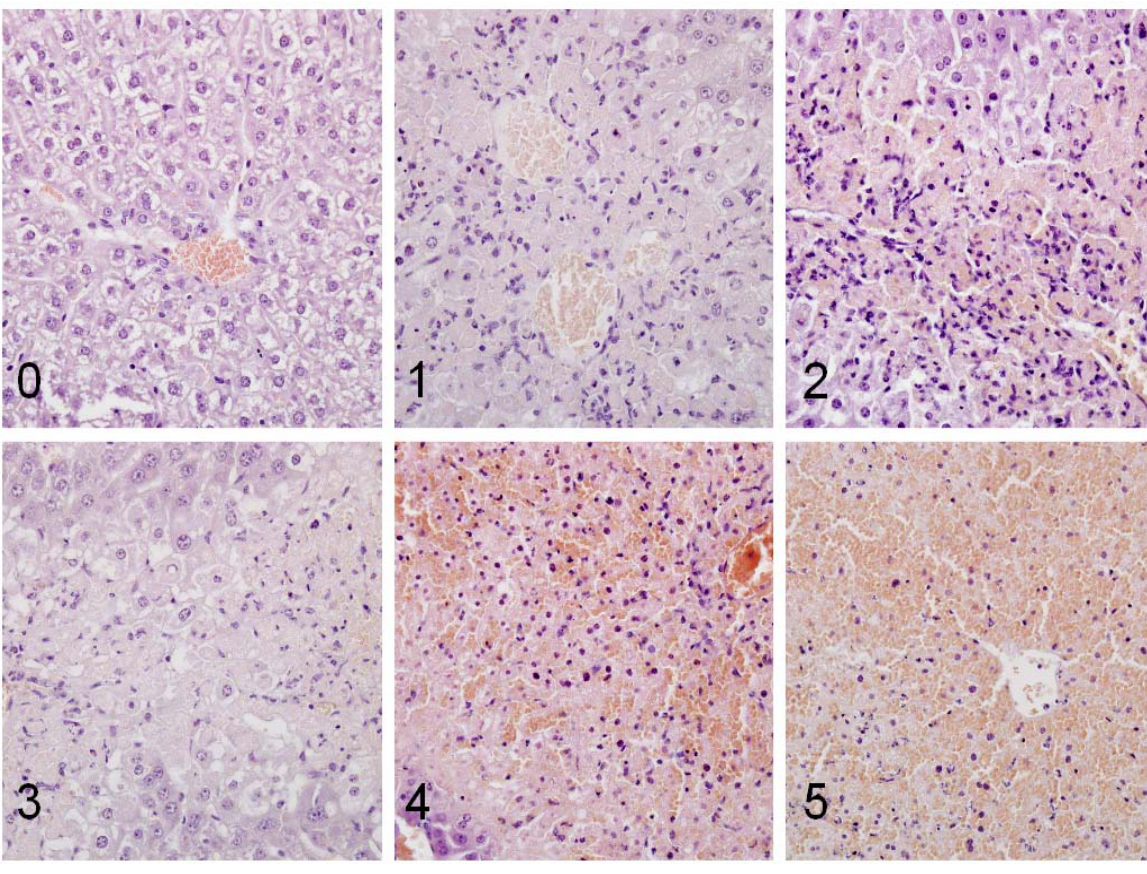
Figure 4. Histopathological analysis of liver sections using a light microscopy (hematoxilin and eosin staining, magnification ×200). Presence and intensity of lesions was graded on a scale from 0 to 5. 0 = no lesions ; 1 = minimal lesions, isolated necrotic cells; 2 = mild lesions, from 10% to 25% of necrotic cells or mild diffuse degenerative changes; 3 = moderate lesions, from 25 to 40% of necrotic cells; 4 = marked lesions, from 40 to 50% of necrotic cells; 5 = severe lesions, more than 50% of necrotic